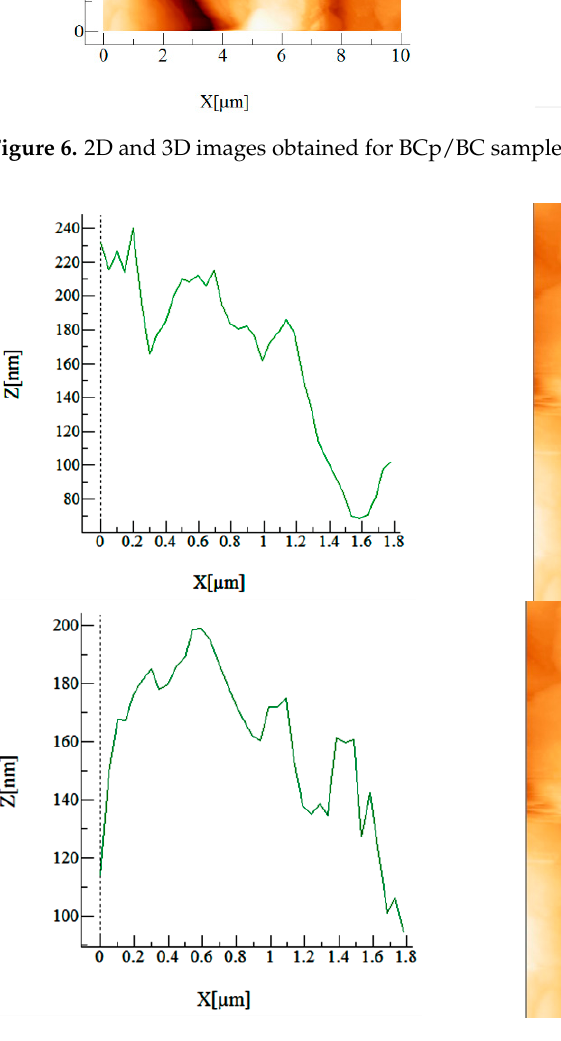
Figure 7. Height and width measurements on the selected area.